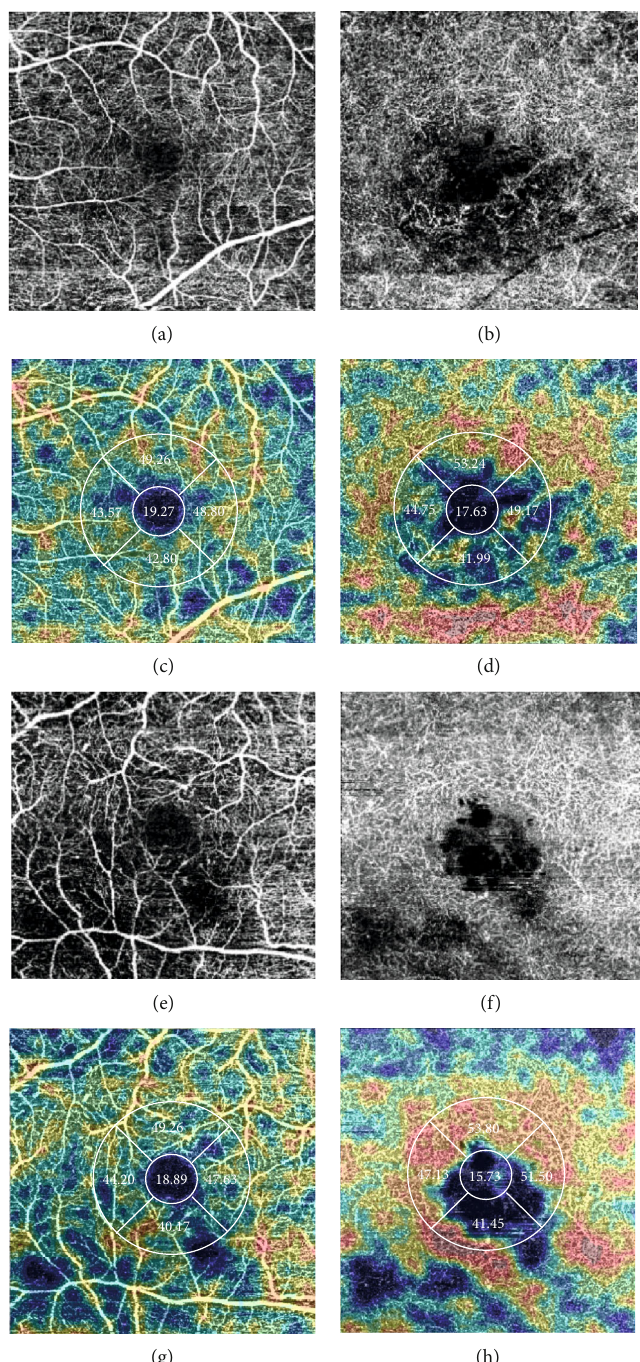
Figure 2: Representative samples of the microvascular parameters relative to the treatment response: (a – d) the parafoveal vessel density in the SCP and DCP (good-response group); (e – h) the parafoveal vessel density in the SCP and DCP (poor-response